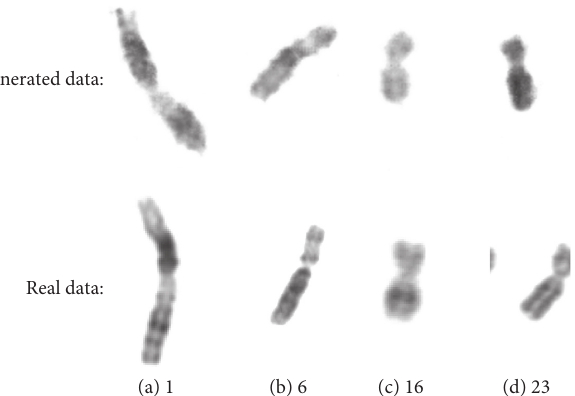
Figure 9: Comparison between real chromosomes and generated chromosomes achieved by MD-GAN, where we can notice gen- erated chromosome images successfully imitate shape invariants of chromosomes. Note that numbers below samples are adopted to represent the corresponding class